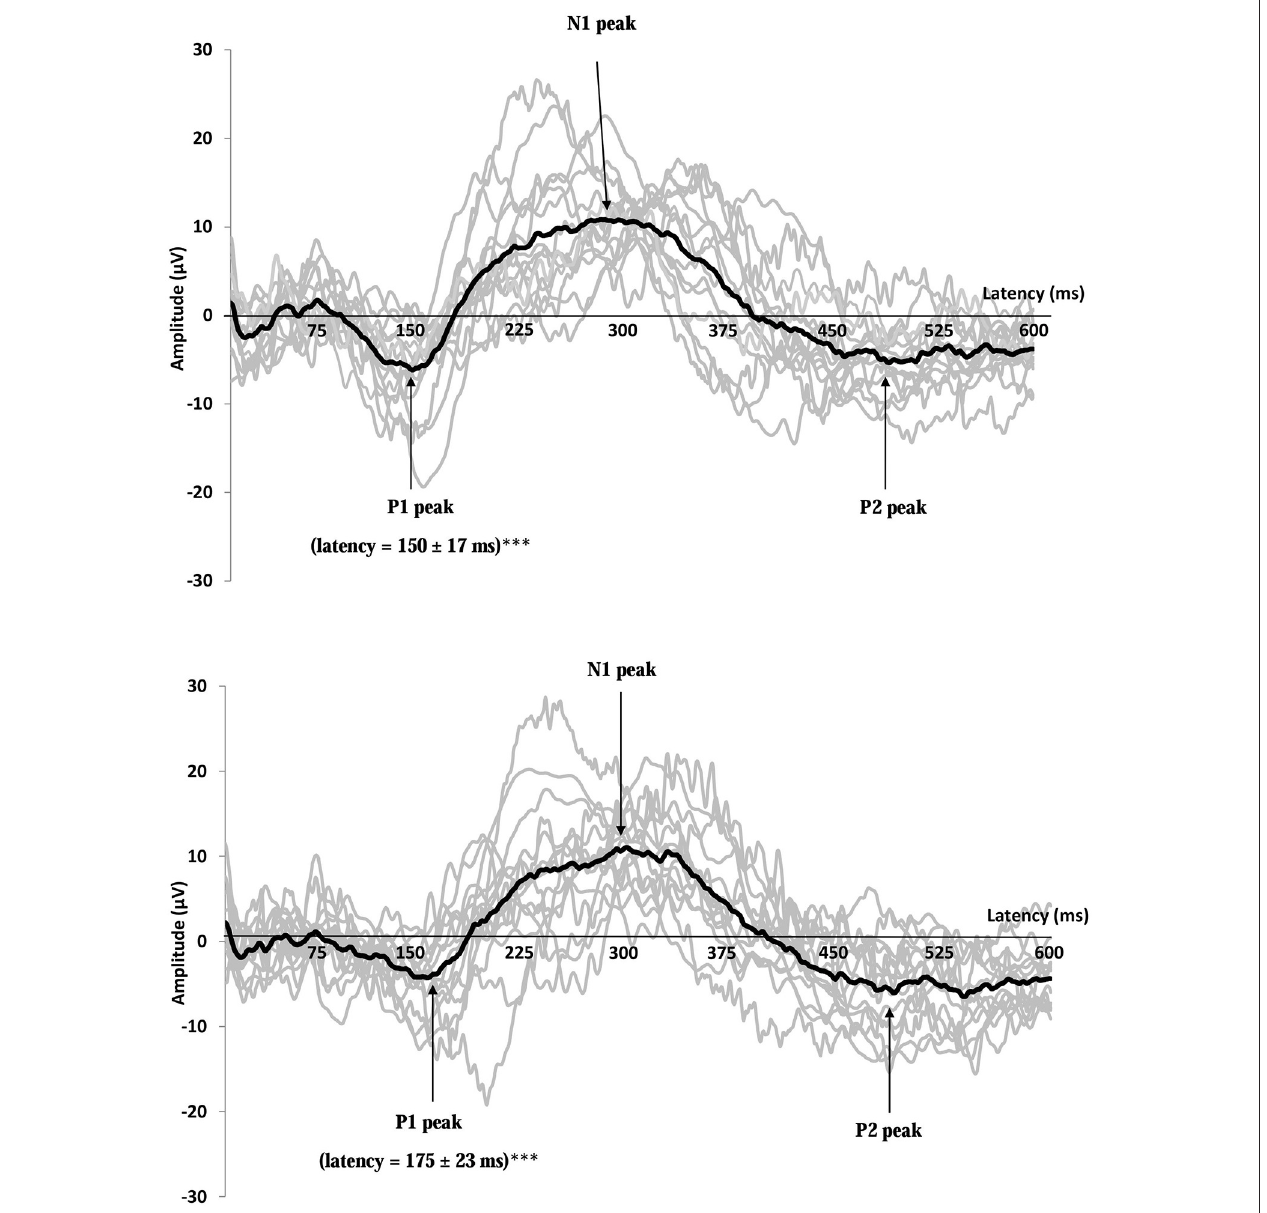
FIGURE 5 | Recordings of gustatory-evoked potentials (GEP) before (top) and after feeding (bottom) in response to a 10g/100mL sucrose solution, on the Cz electrode. Both figures show the average of GEPs of the 15 participants after stimulation by the sucrose solution (for each subject, the curve corresponds to an average of 20 stimuli). GEP was defined by three peaks: P1 the first positive peak, N1 the higher negative peak and P2 the second positive peak. GEP latency in the primary gustatory cortex was prolonged after food intake *** p < 0.001 .